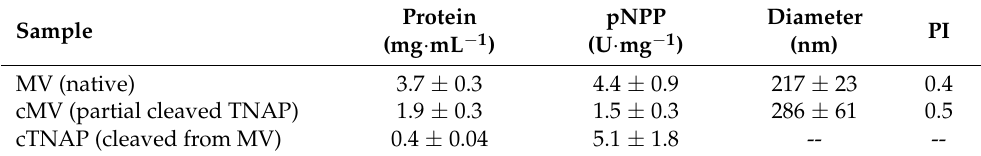
Table 2. Biochemical and biophysical characterization of MV; cMV and cTNAP obtained after treatment with PI-PLC as described in Materials and Methods. MV were treated with PI-PLC during 3 h, ultracentrifuged at 80,000 × g . The supernatant contained cTNAP, and the pellet composed of cMV was resuspended in SCL without phosphate. Protein determination was assayed by the Bradford method [76]. TNAP activity in MVs isolated from chondrocytes, was measured continuously